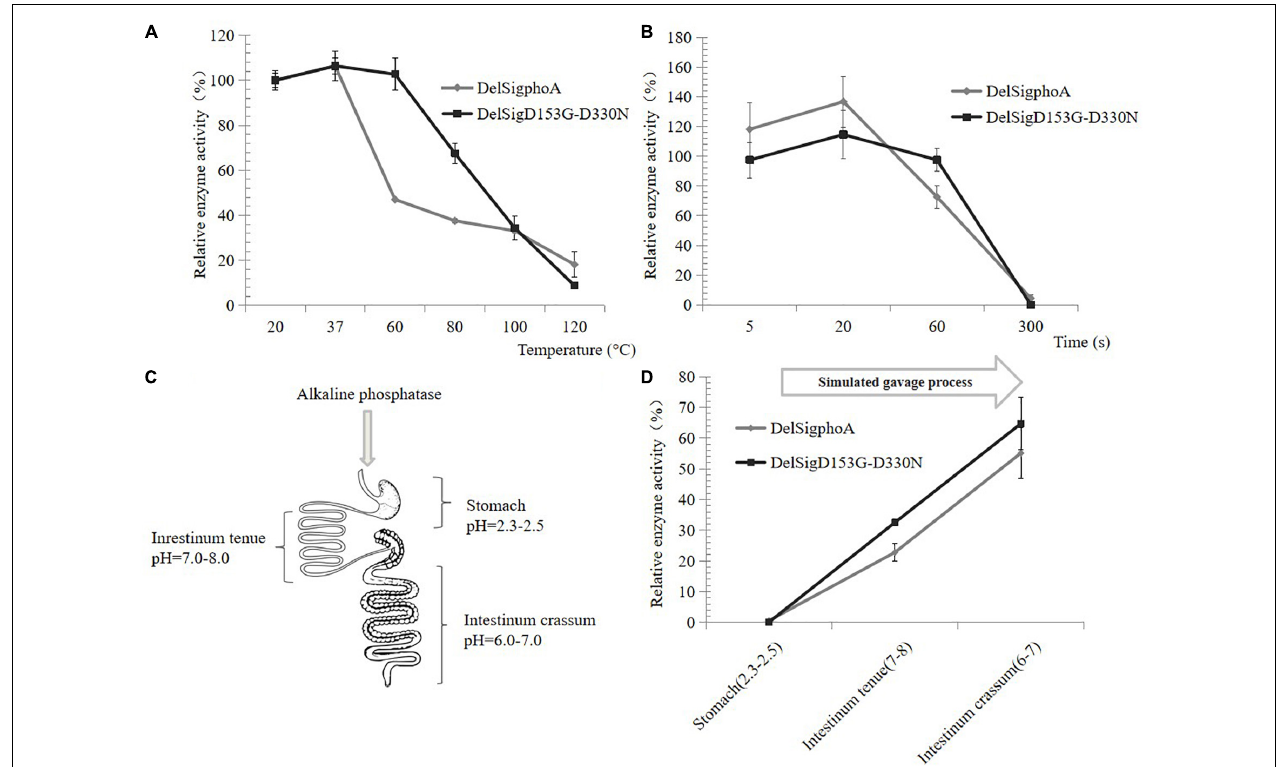
FIGURE 3 | Heat, acid, and alkali stability of AKP. (A) Heat stability of AKP on different temperatures. (B) The effect of incubation time at 120 ◦ C on AKP activity. Control is the vector. (C) Schematic diagram of piglet gastrointestinal after absorption of the AKP. (D) The effect of AKP on acid and alkali environment for simulating gavage process. Error bars, SD; n =